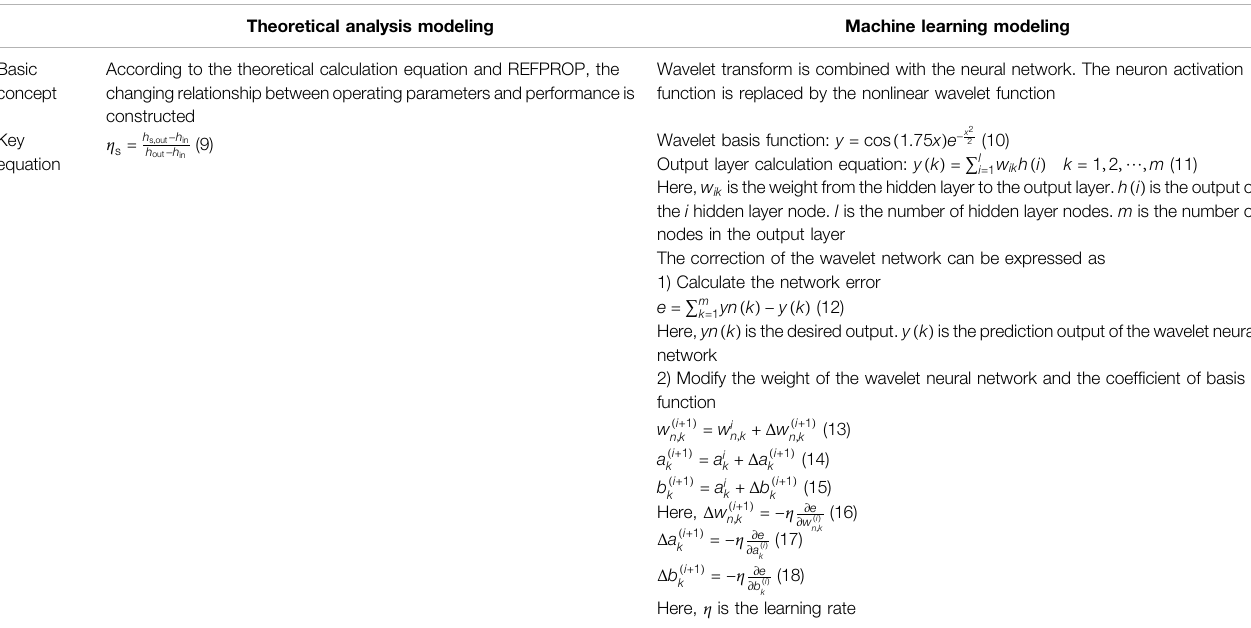
TABLE 5 | Differences between theoretical analysis modeling and machine learning